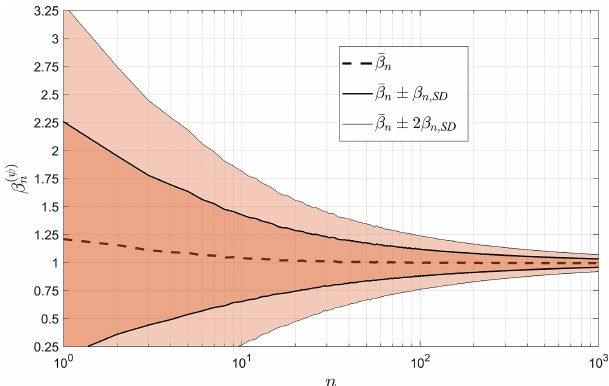
Figure 8. The ratio between modeled and observed cumulative ice mass loss computed using the Monte Carlo method, with n events randomly selected (with repetition) from the entire calving inven- tory. The selection procedure was repeated ψ max = 10000 times for each n . See text for details of the modeled ice mass loss cal- culation. The thick and thin solid lines, respectively, denote 1- and 2-standard-deviation boundaries of the